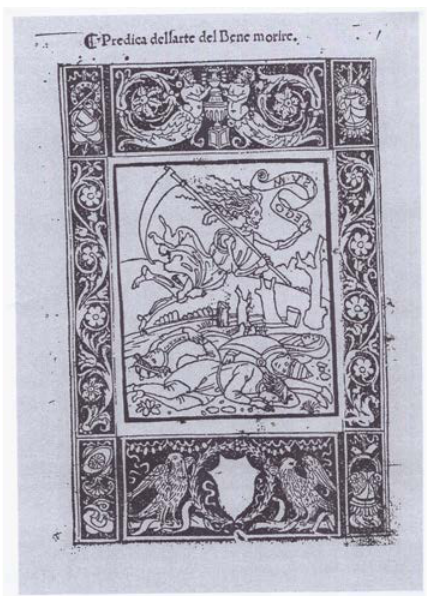
Figure 4 – Girolamo Savonarola, Predica dell’arte del Bene morire , s.n.t. [but Firenze, Bartolomeo de’ Libri, after november 2, 1496), f. 1r (BNCF, Cust. E 6). By permission of Ministero per i beni e le attività culturali / Biblioteca Nazionale Centrale. Firenze